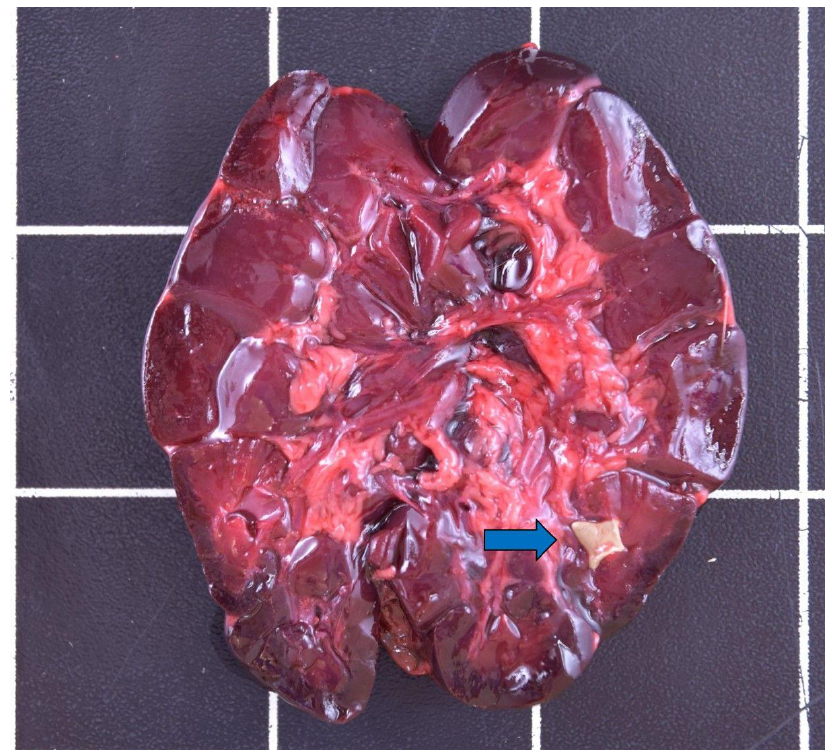
Figure 7. Nephrolithiasis (blue arrow) in the kidney of a male otter from Schleswig-Holstein. Cysts on the vas deferens (Figure 8) were present in 18 male otters (~0.5–7.5 years). Most findings of cysts occurred in 2020, which most likely represents the lack of awareness of such alterations during necropsies in earlier years.